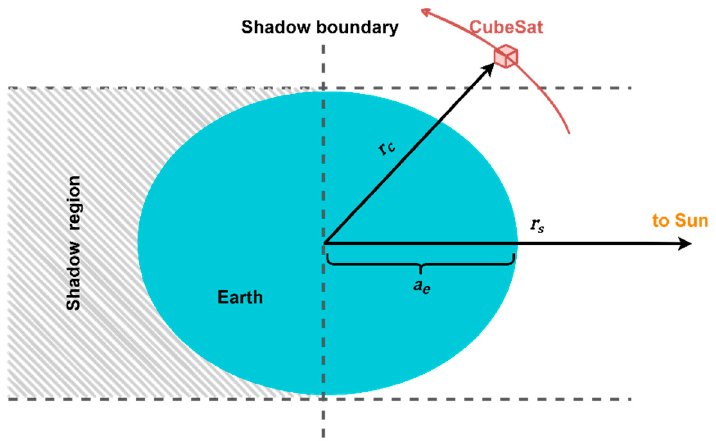
Figure 5. Cylindrical model for detecting CubeSats located in the shadow of the earth.